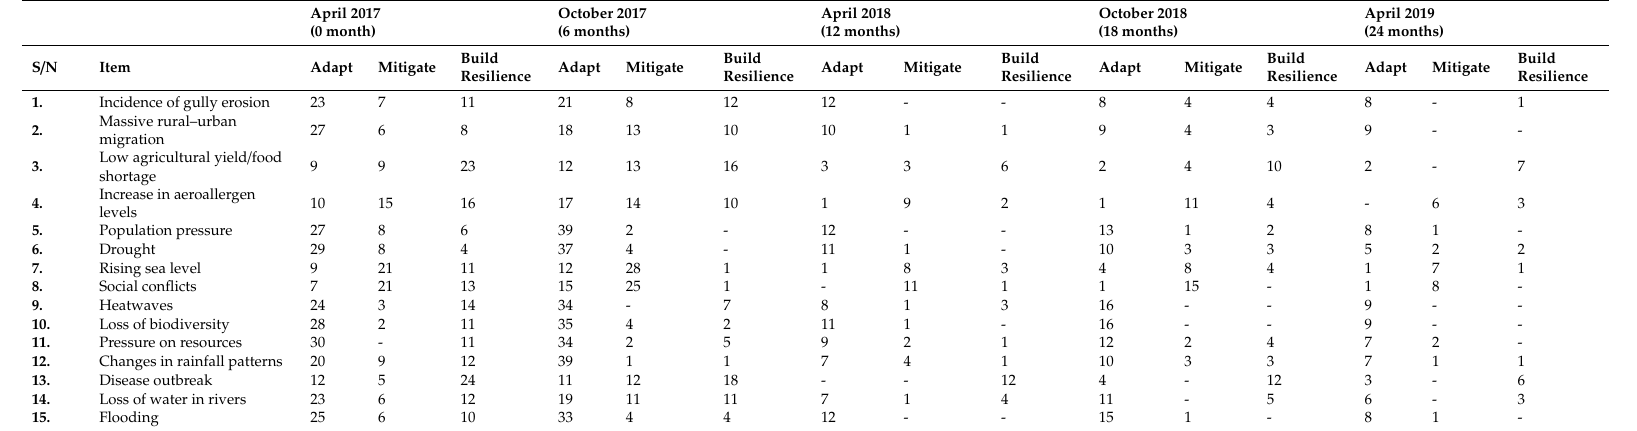
Table A3. Breakdown of questionnaire responses / results for CC challenges in